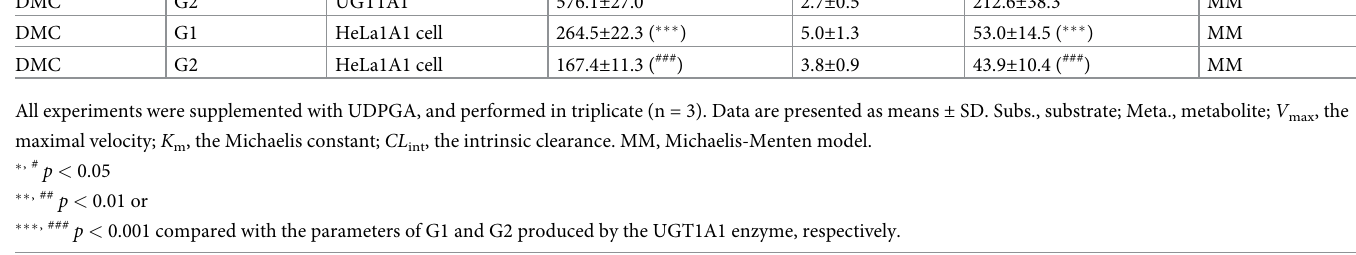
( p > 0.05) (Table 1), whereas obvious differences ( p < 0.001) were observed in the V CL int values (Table 1). Similar results were obtained for the parameters of G2 (Table 1). An